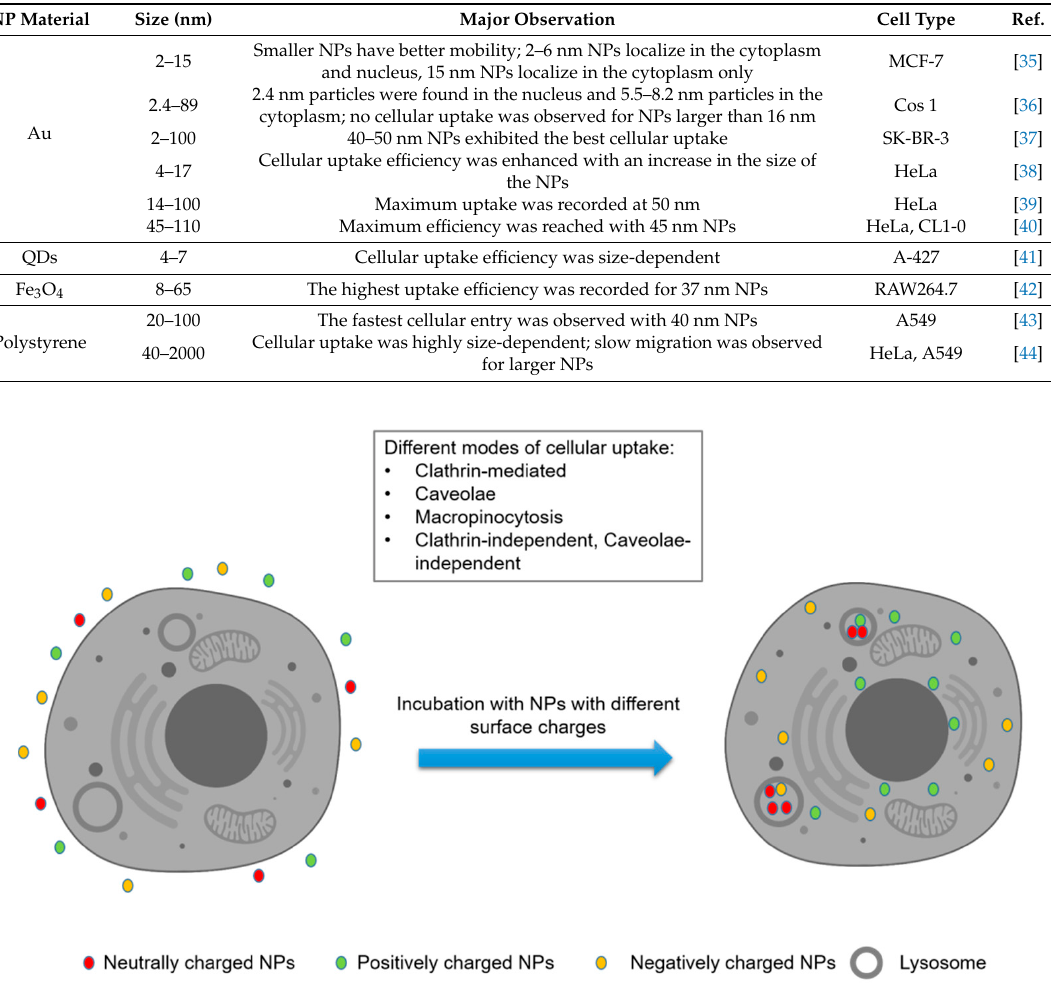
Table 1. Comprehensive list of widely studied nanoparticles (NPs) and their internalization efficiency based on size.